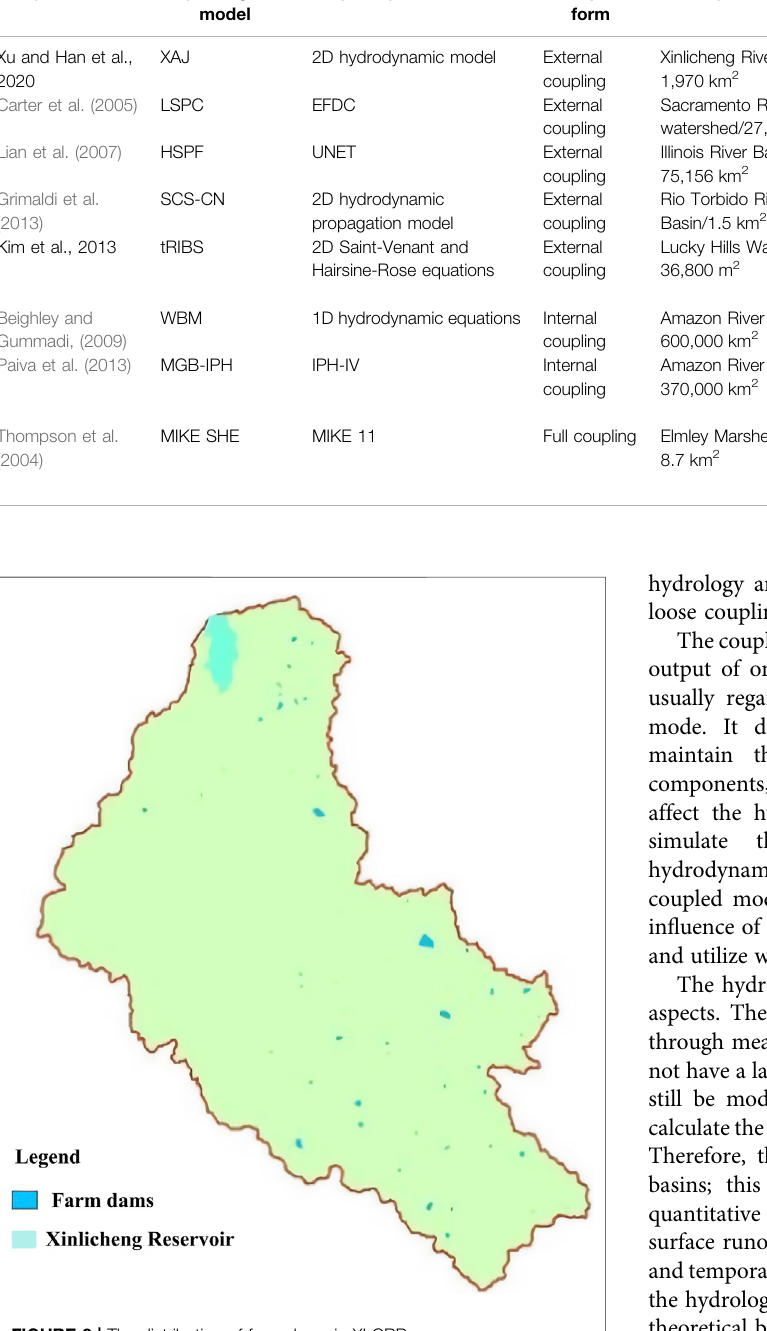
FIGURE 8 | The distribution of farm dams in